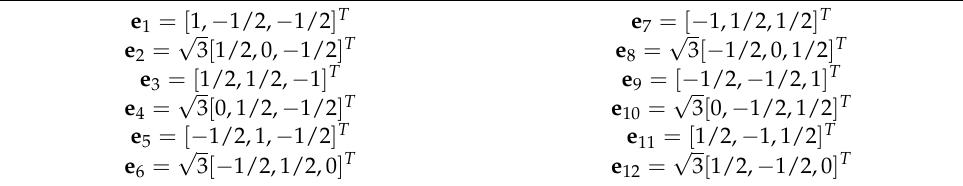
Table 1. List of basis vectors for the creation of phase imbalance in the initial